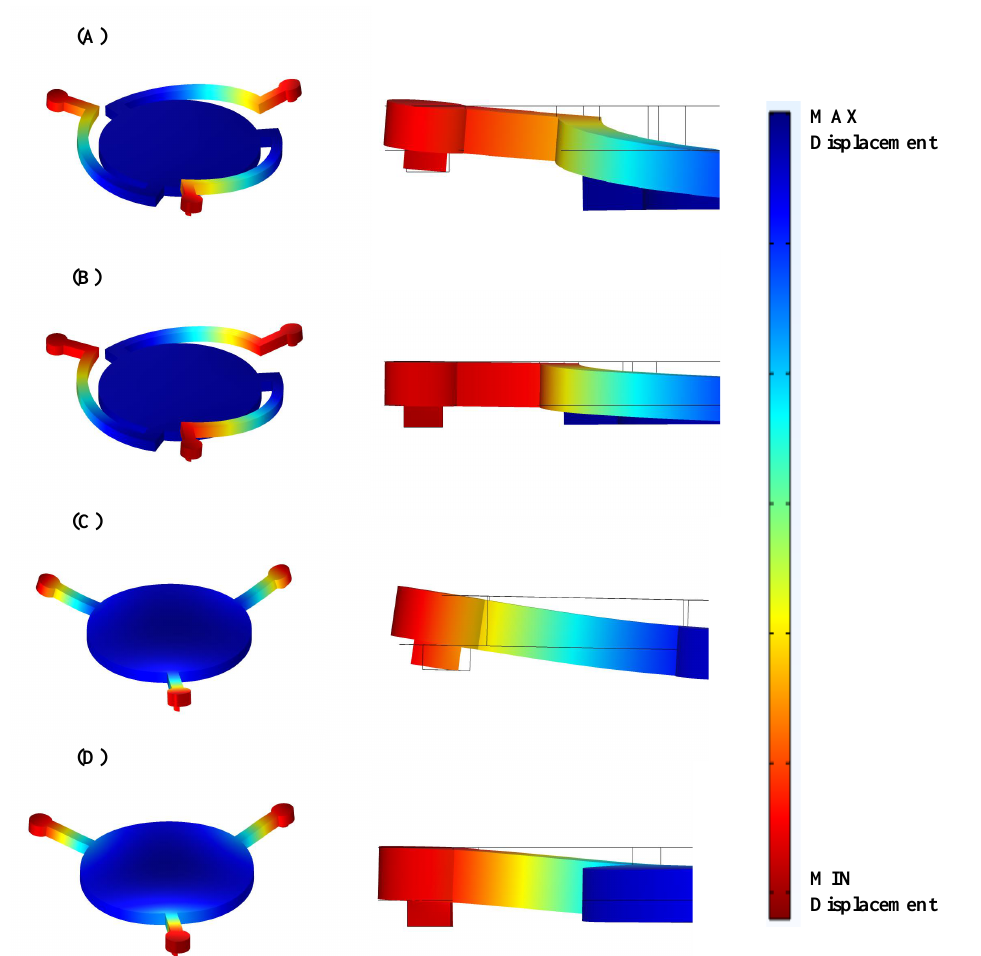
Figure 9. Scaled-up deformation of CMUTs under operation. ( A ) CMUT A. ( B ) CMUT B. ( C ) CMUT C. ( D ) CMUT